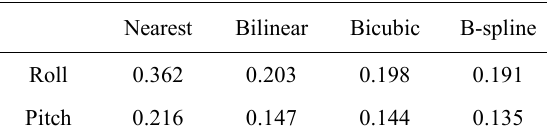
Table 1. Root-mean-square deviation compared with attitude measurement data (Unit: arc second).